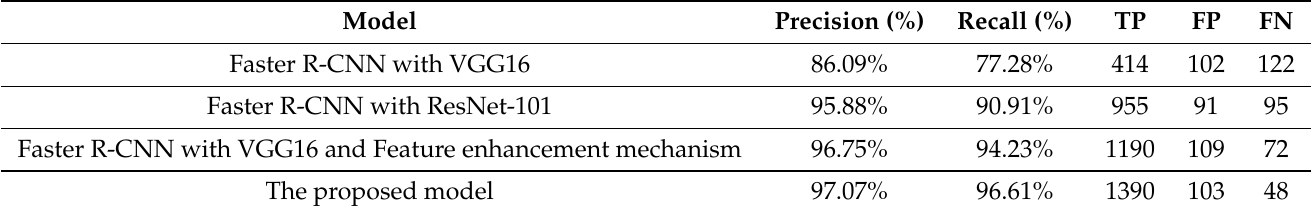
Table 2. Numerical comparison of the Faster R-CNN model based on the backbone network.